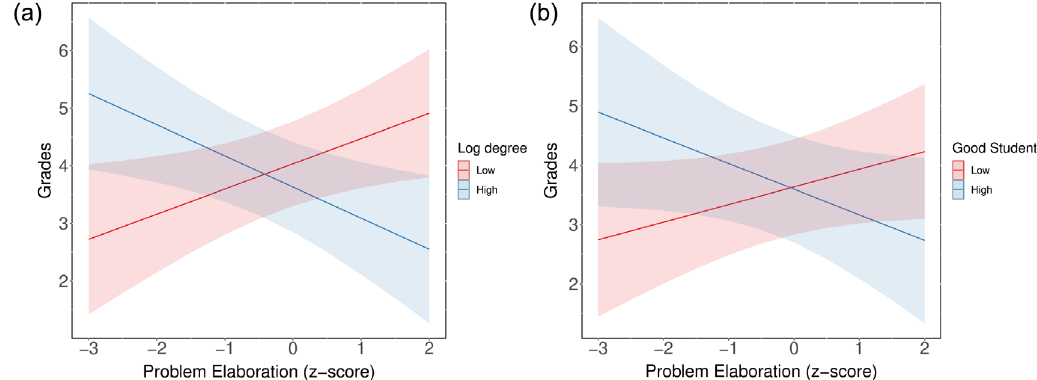
FIG. 8. Interaction between problem elaboration and (a) The logarithm of node degree, and (b) Good student nominations, both from a linear model predicting physics grades. The shaded areas represent a level of confidence interval of 0.9 and low (high) intervals contain the values below (above) the mean of each